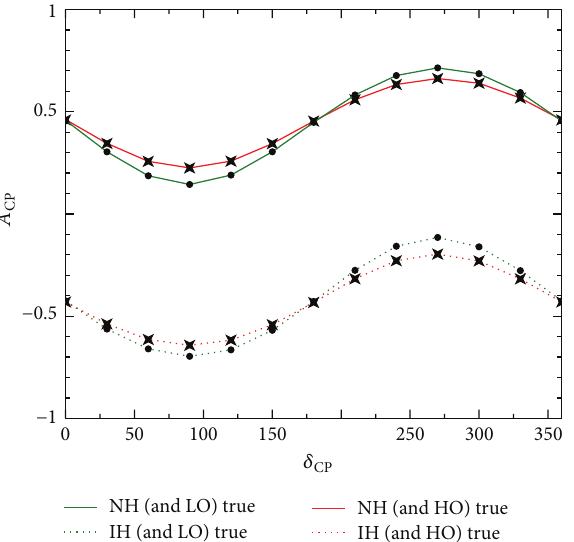
Figure 1: CP asymmetry versus 𝛿 hierarchies. Red and green solid (dotted) lines are for NH (IH) with types of curve to distinguish HO and LO as the true octant,